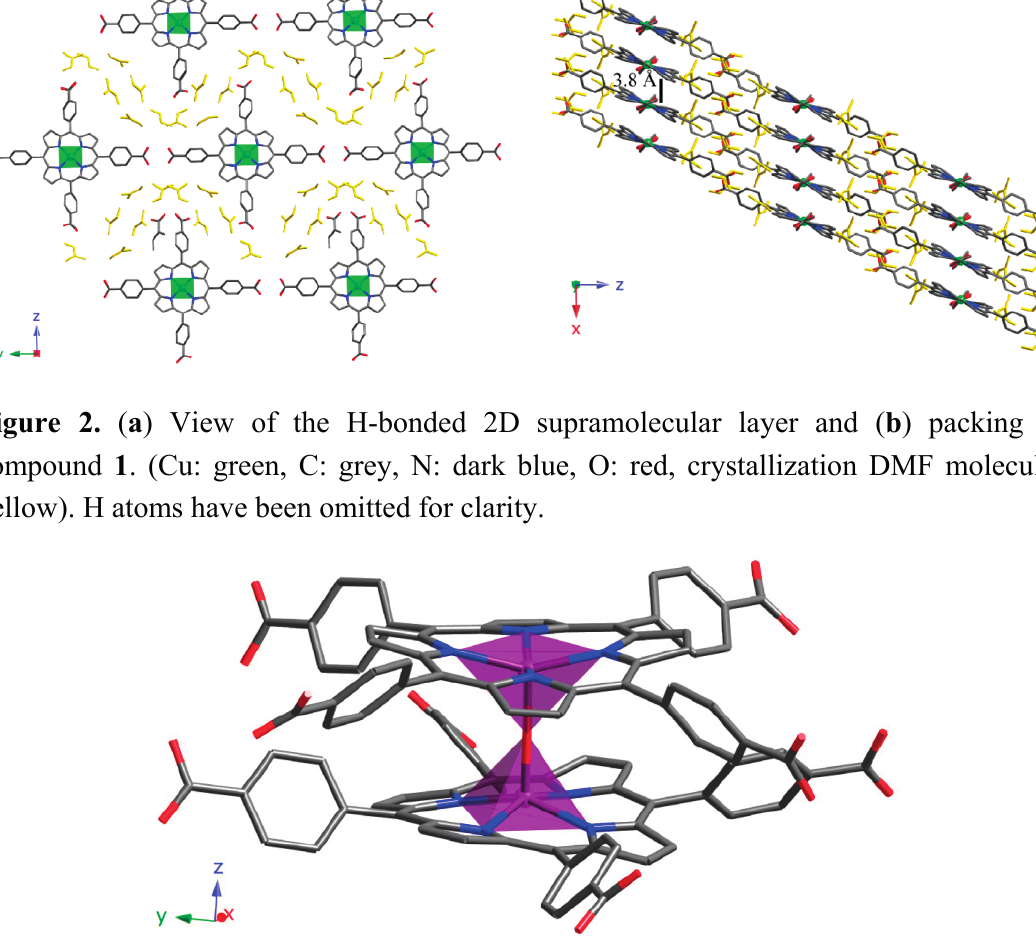
Figure 3. Dimeric unit for compound 2 . (Fe: purple, C: grey, N: dark blue, O: red). H atoms have been omitted for